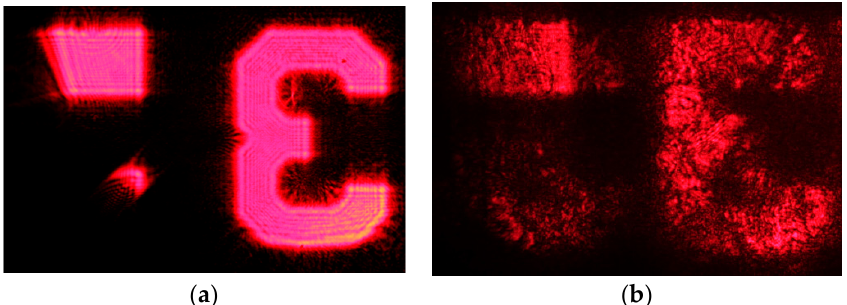
Figure 11. ( a ) Test image. ( b ) Image observed in the couple out hologram.